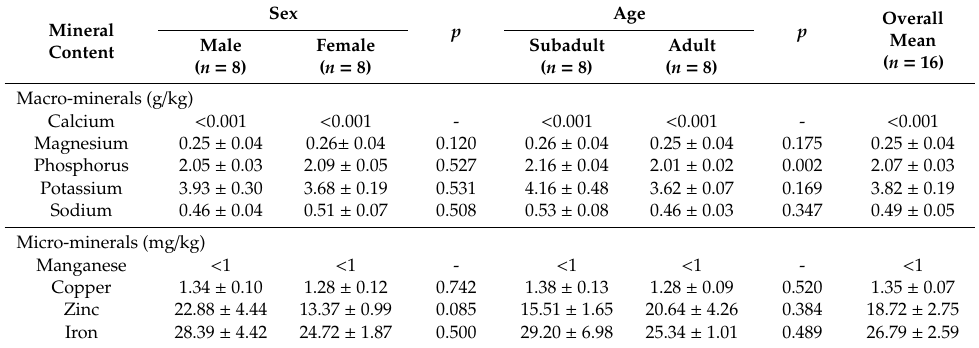
Table 4. Mineral composition and content of axis deer longissimus thoracis , as influenced by sex and age (mean ±